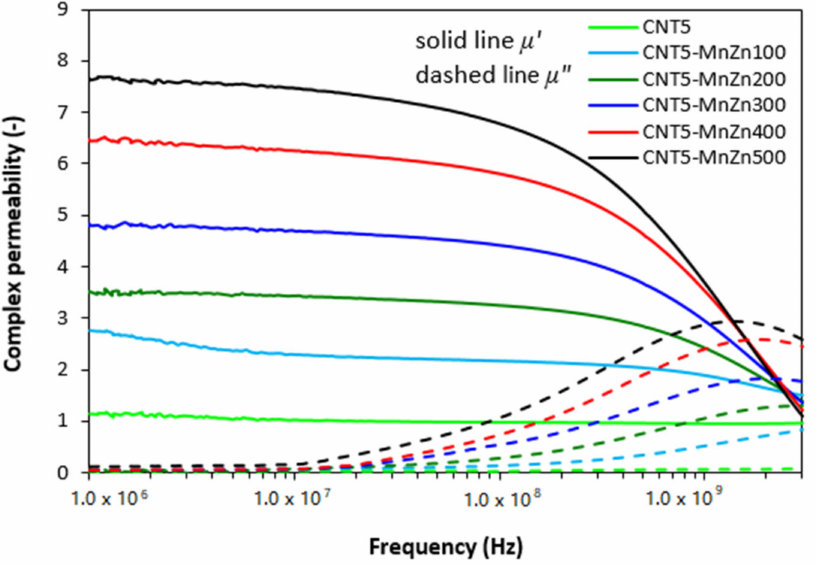
Figure 7. Frequency dependences of real ε (cid:48) and imaginary ε (cid:48)(cid:48) parts of complex permeability for hybrid CNT/ferrite filled